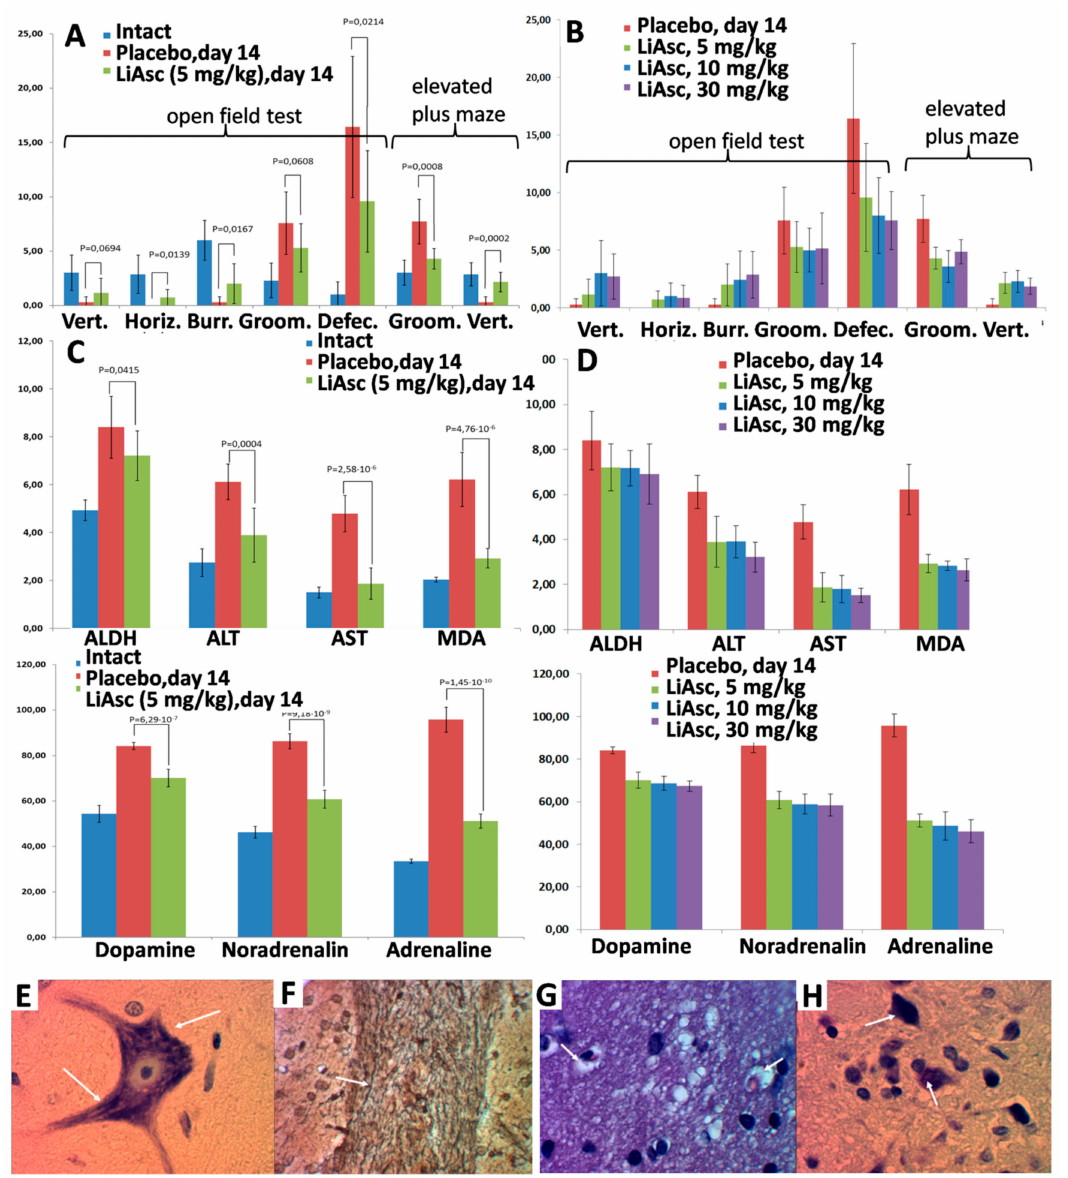
Figure 4. Effects of “prophylactic” use of lithium ascorbate in animals with the model of alcohol intoxication. ( A ) Indicators of neurological tests, 5 mg/kg. ( B ) Dose-dependence, neurological tests. ( C ) Biochemical indicators. ( D ) Dose-dependent effects on biochemistry. ( E ) Histological effects of lithium ascorbate. Focal fusion of Nissl lumps in the cytoplasm of the pyramidal cell. Nissl staining with toluidine blue. Magnification × 1200. ( F ) Clear contrasted contours of the commissural fibers of the brain with preservation of the integrity of the myelin sheath. Silver impregnation. Increase × 1200. ( G ) Histological picture. Pronounced pericapillary edema of the nervous tissue. Staining with hematoxylin and eosin. Magnification × 1200. ( H ) Hyperchromatosis, pycnosis of neurocytes. Astrogliocyte hypertrophy. Nissl staining with toluidine blue. Magnification ×